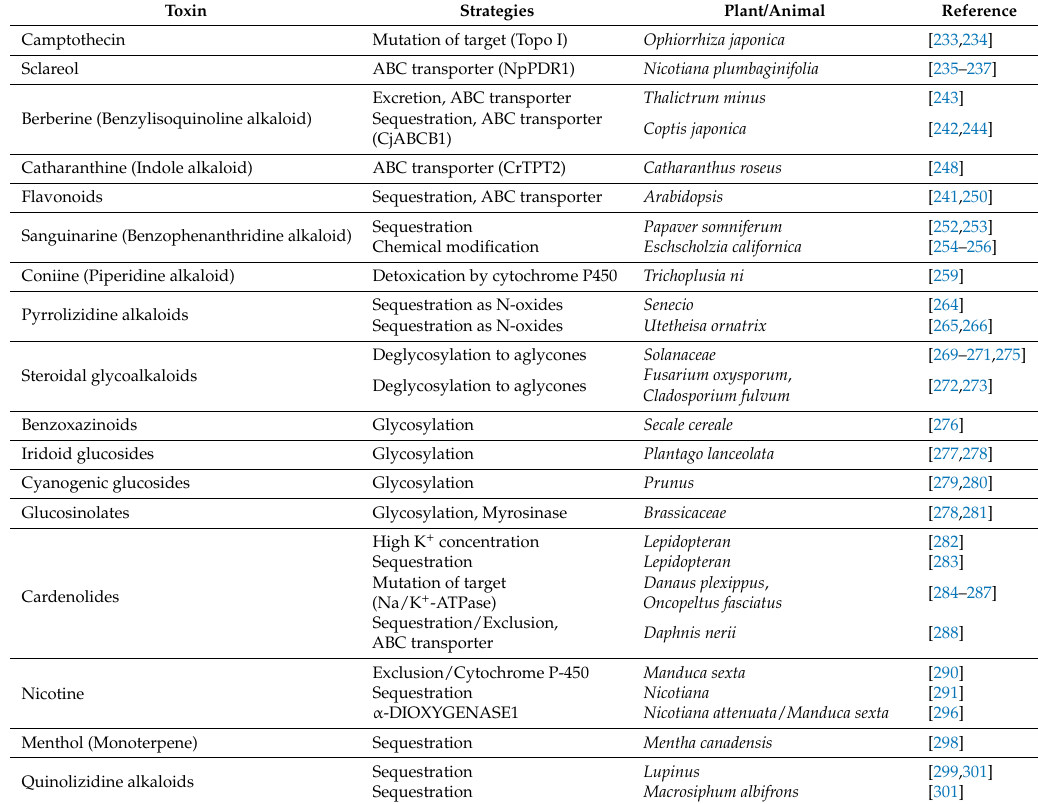
Table 3. Toxin resistance-related strategies in